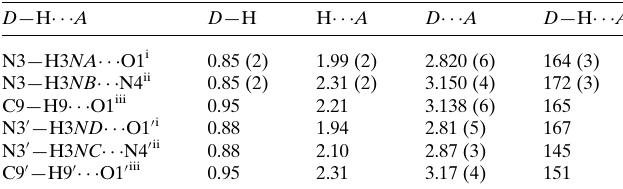
Table 2 Hydrogen-bond geometry (A˚ , (cid:3)